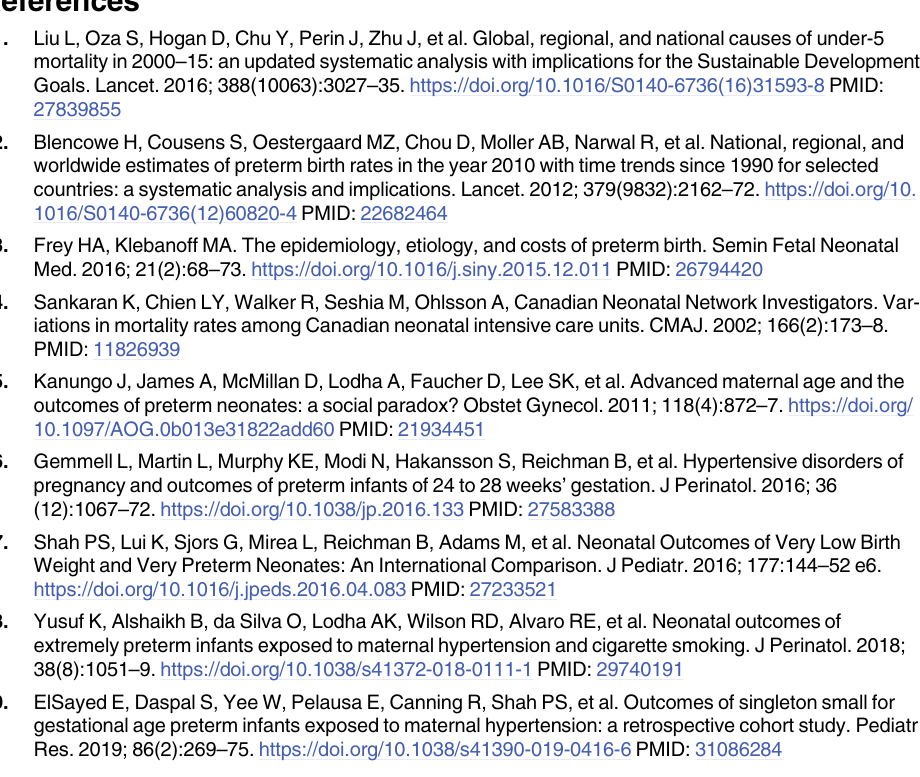
S6 Fig. Directed acyclic graph of relationships between NICU practices and perinatal deaths (A) and between hospital or region of residence and perinatal death (B). (TIF) S1 Table. Comparisons of rates of early neonatal death rates at 24–31 weeks’ gestation and overall among singletons with no congenital or chromosomal anomaly, 2006–2015. (PDF) S1 Appendix. Example of an antenatal exposure associated with gestational age at birth, resulting in a paradoxical association with mortality among very preterm